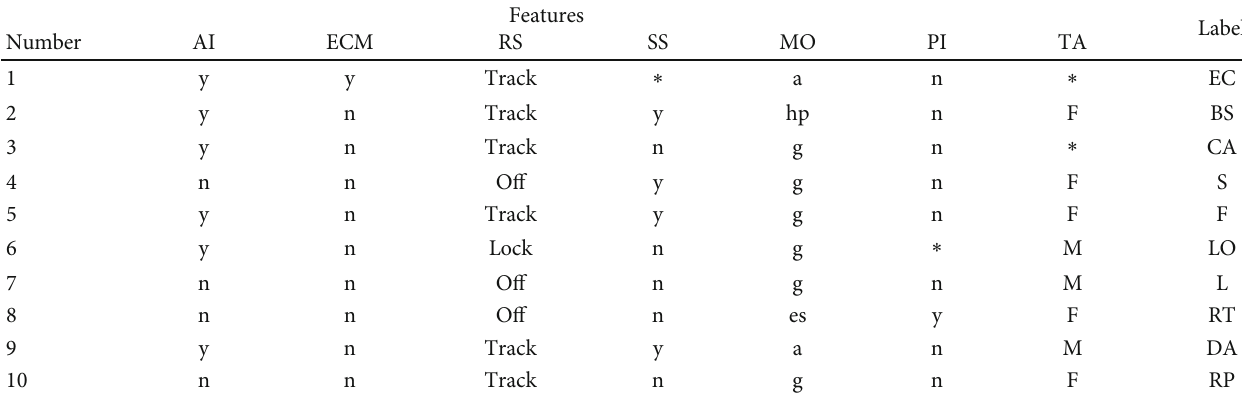
Figure 15: Feature extraction of enemy attack tendentiousness. The horizontal coordinate is the time axis. The line chart at the top of the picture shows the results of two aircraft ’ s threat assessment to red3. The stacked histogram in the lower part of the image represents the extracted attack tendency features. Table 6: Features and labels of some